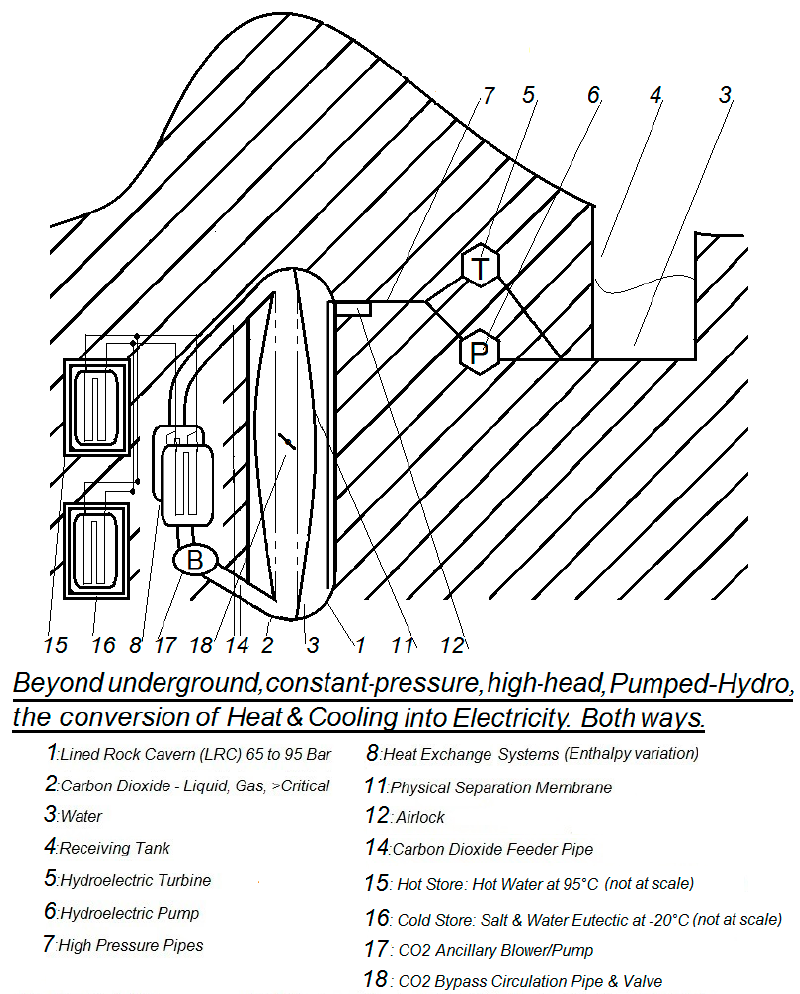
Figure 8. Main components of the hybrid UPHES-PTES for long-duration storage (here in stand-alone configuration and without the smaller pressurized cavern dedicated to CO 2 ). UPHES for storage of short and medium duration uses the same components, except for the absence of the two large thermal stores.